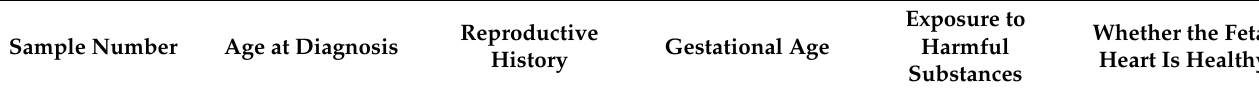
Table 2. Clinical features for pregnant women with a healthy fetal